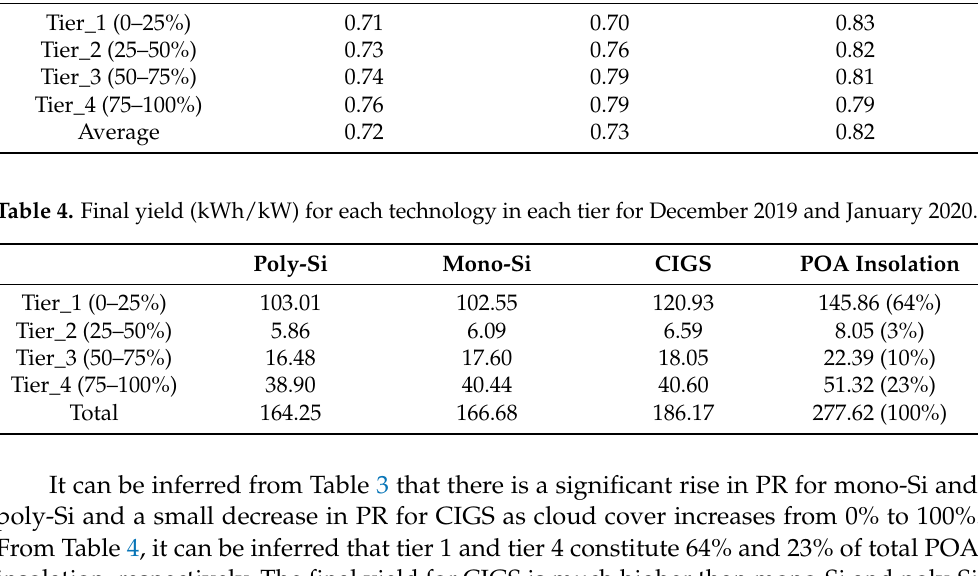
Table 3. Average PR for each technology in each tier for December 2019 and January 2020. Poly-Si Mono-Si